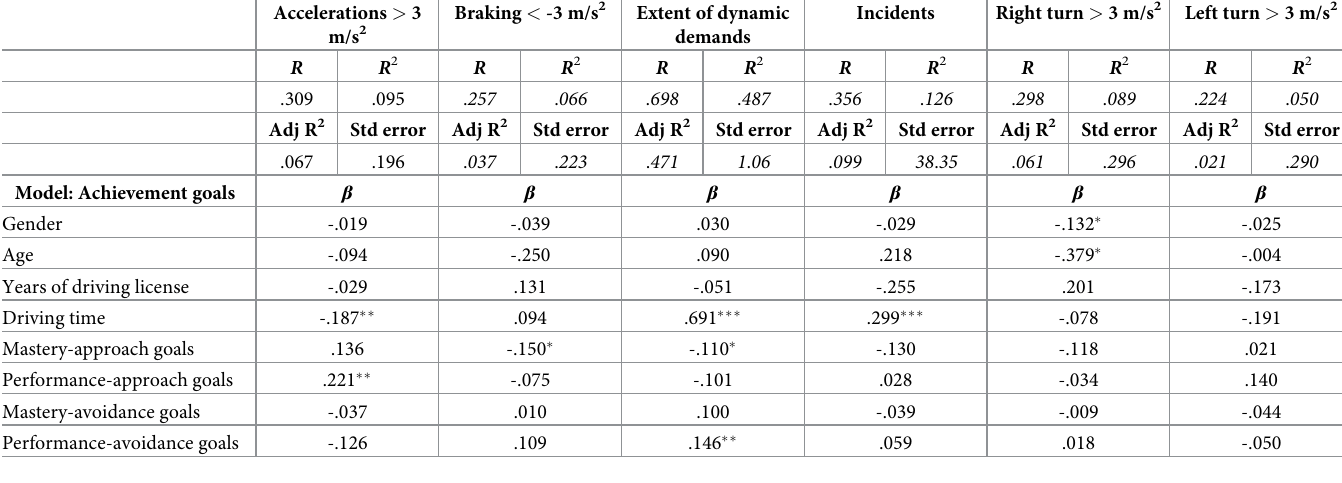
Table 2. Results of the regression